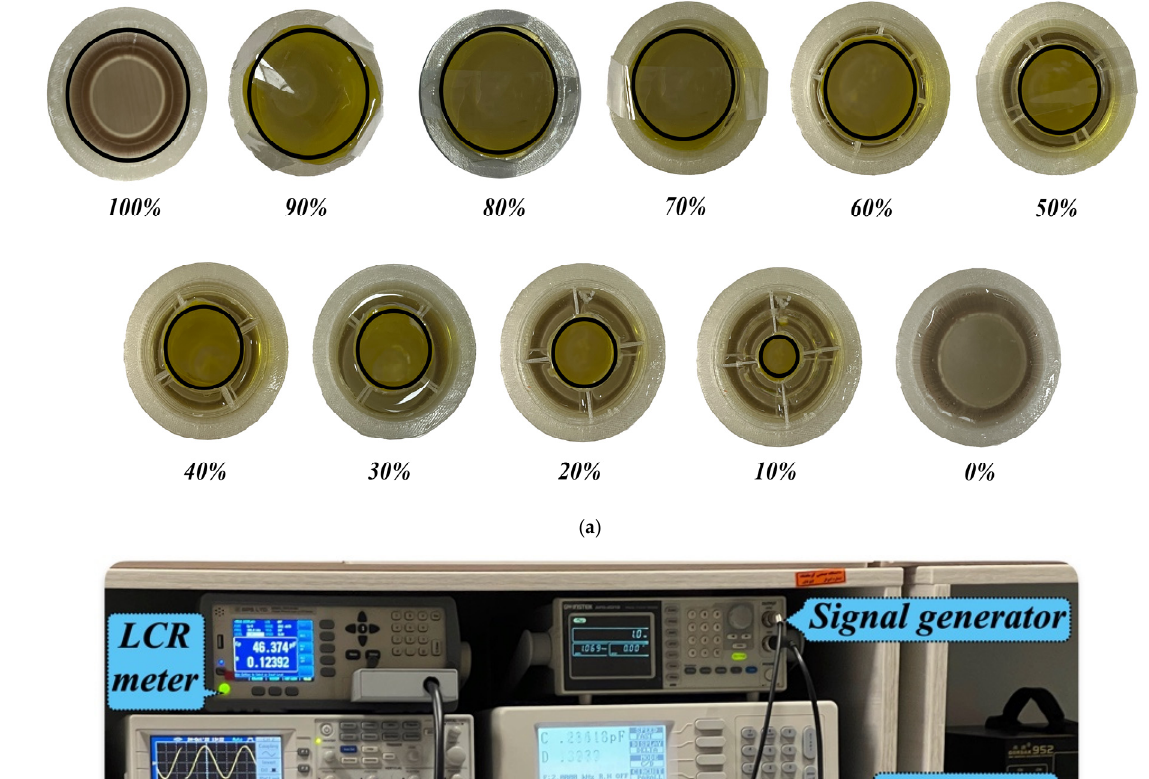
Figure 5. Fabricated capacitance-based concave sensor.